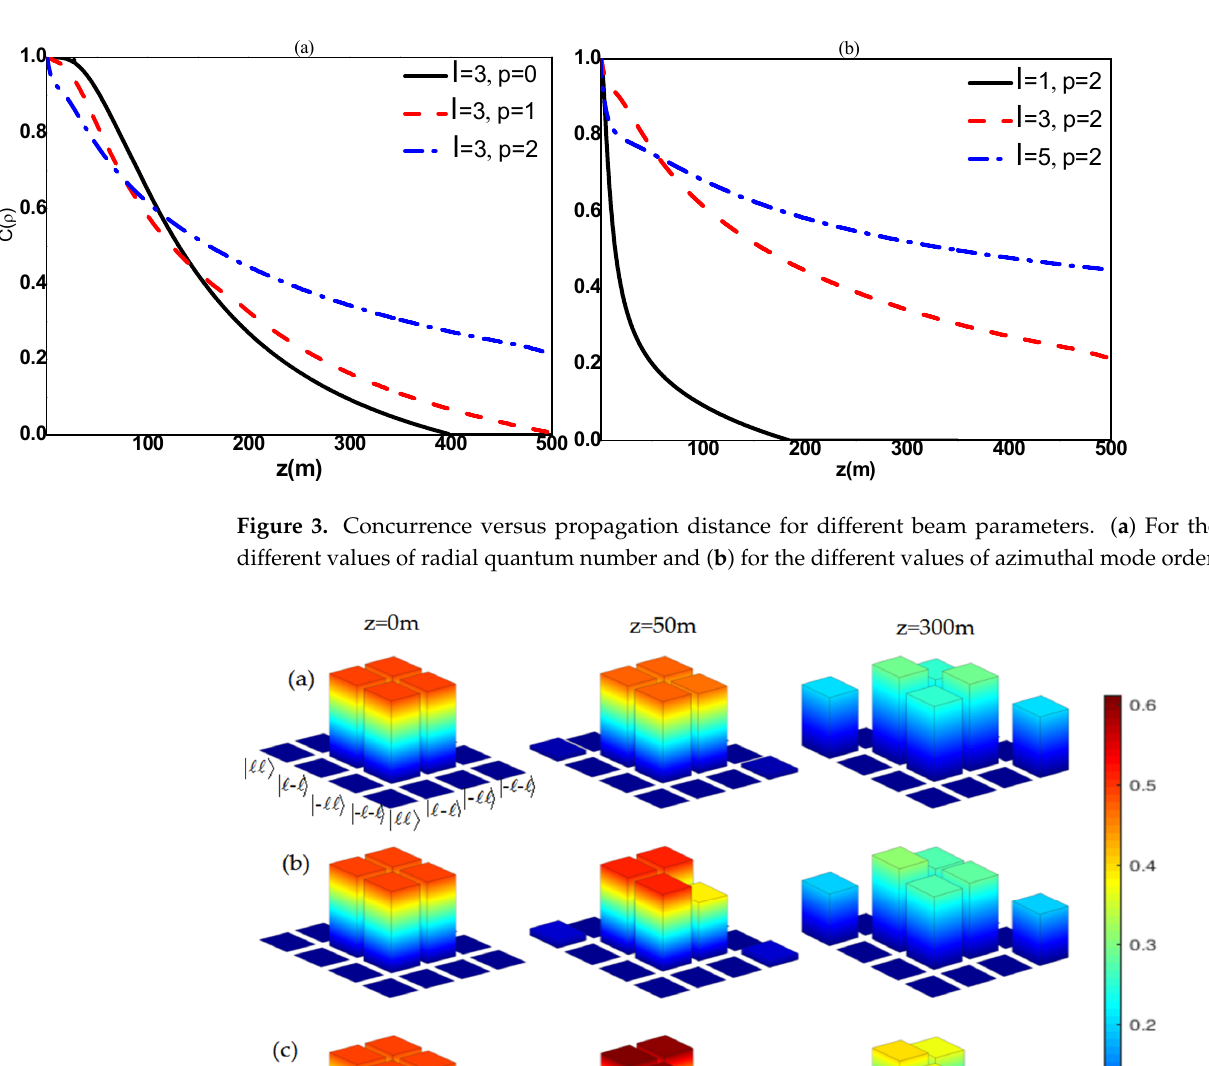
z=20m z=100m z=300m Figure 5. Concurrence plotted as the turbulence parameters for different propagation distances ( a ) of generalized exponent, ( b ) of refractive-index structure parameter, ( c ) of turbulence outer scale, and ( d ) of turbulence inner scale.